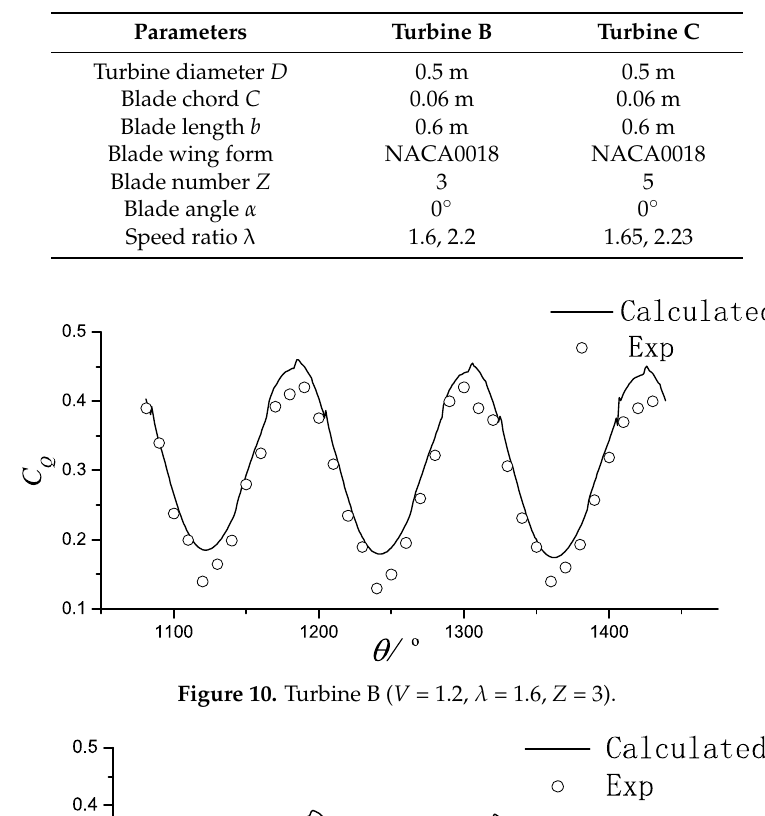
Table 2. Parameters of the model test.